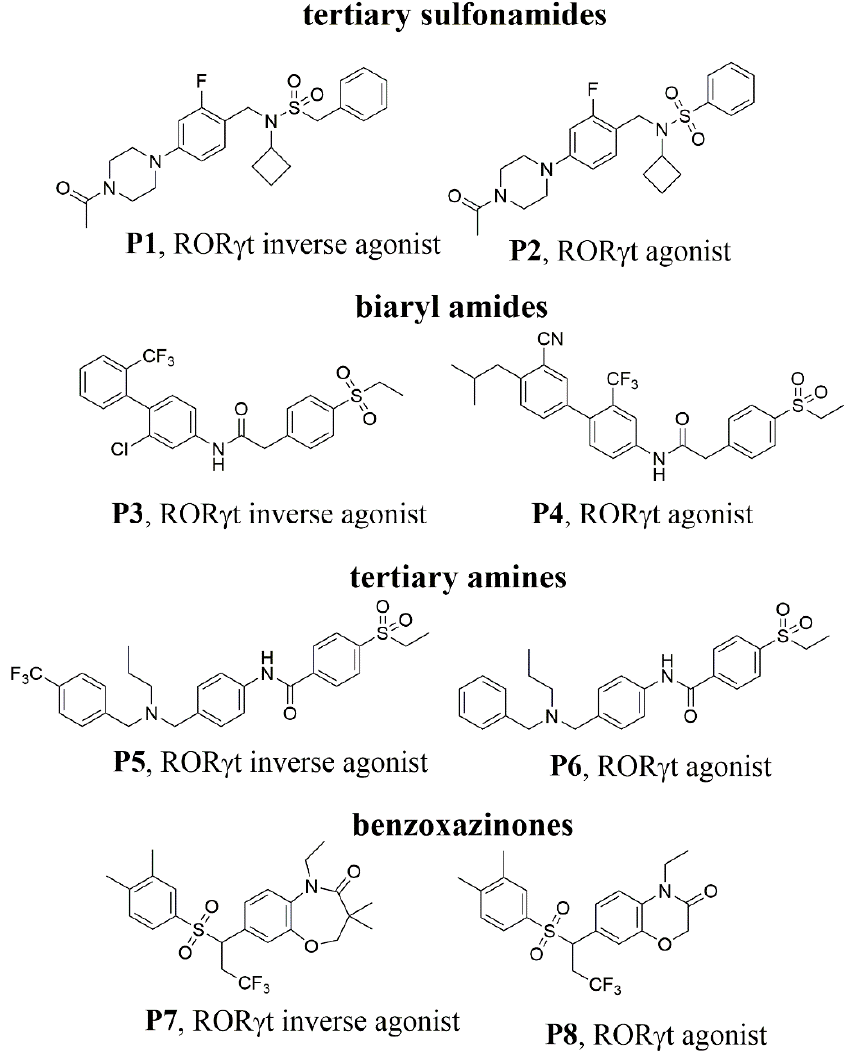
Figure 2. Molecular structures of published ROR γ t agonists and inverse agonists.